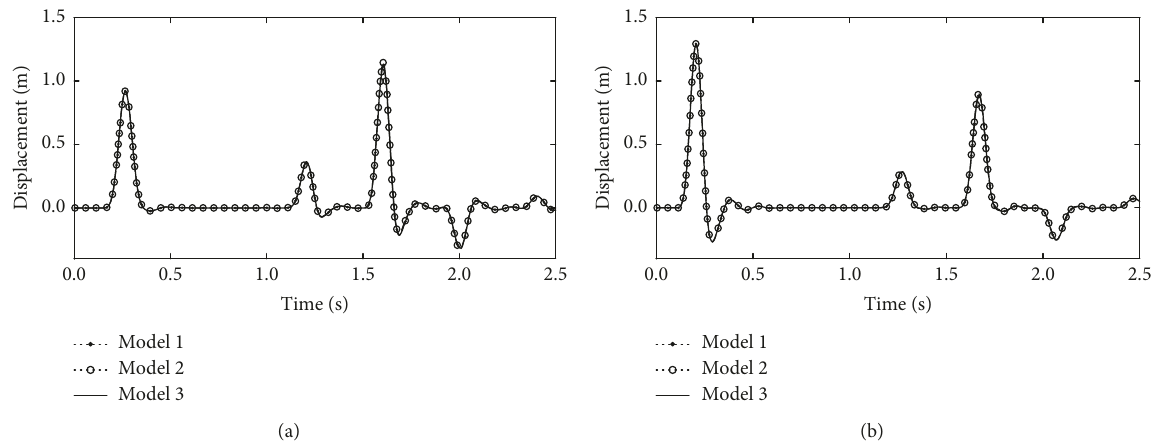
Figure 11: Displacements of the observation points: (a) Point A and (b) Point